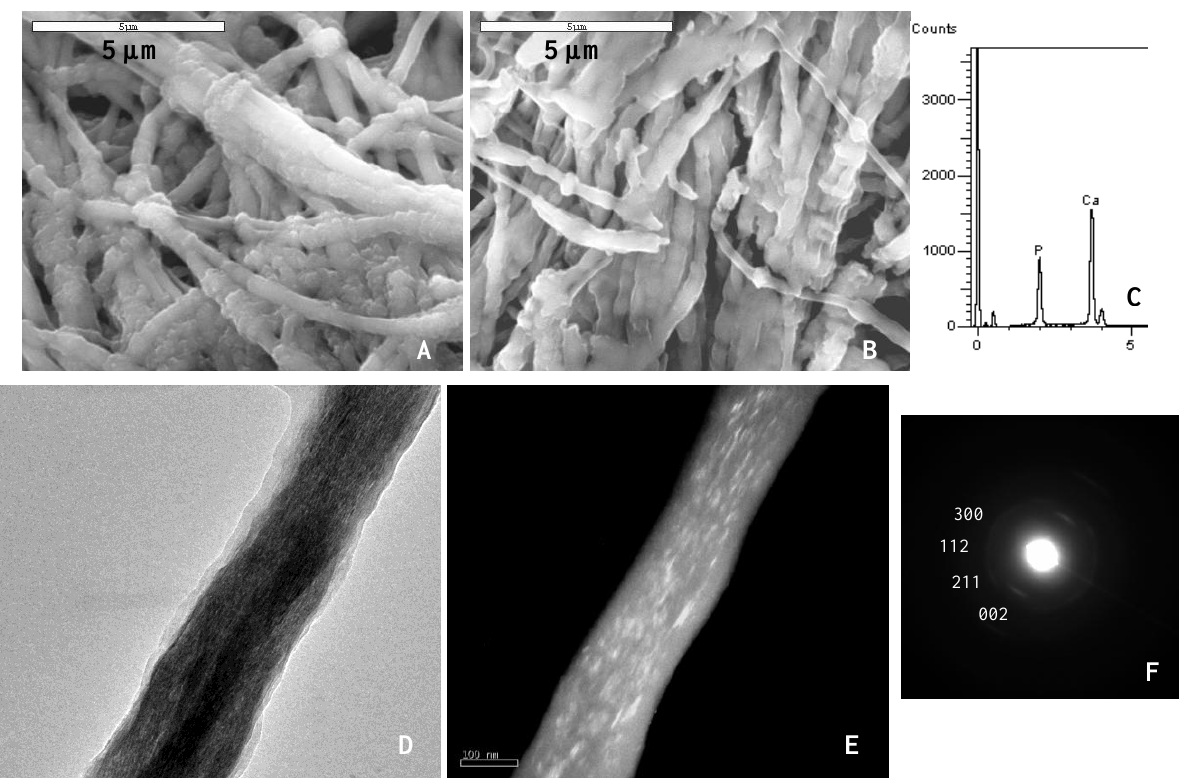
Figure 5. SEM/EDS and TEM micrographs of PILP-mineralized collagen samples using 27-kDa poly-L-aspartic acid as the polymer directing agent. SEM of the surface ( A ) and the inner-section ( B ) of a mineralized collagen sponge treated with PILP solution containing 50 µg/mL PASP27 for 3 days. ( C ) EDS of the inner-section of a mineralized collagen sponge treated with PILP solution containing 50 µg/mL PASP27 for 3 days. ( D ) Bright- and ( E ) Dark-field TEM micrographs of an isolated PILP-mineralized collagen fibril. Bar = 100 nm. The dark-field image was constructed by selecting the (002) arc with the objective aperture from the SAED pattern shown in ( F